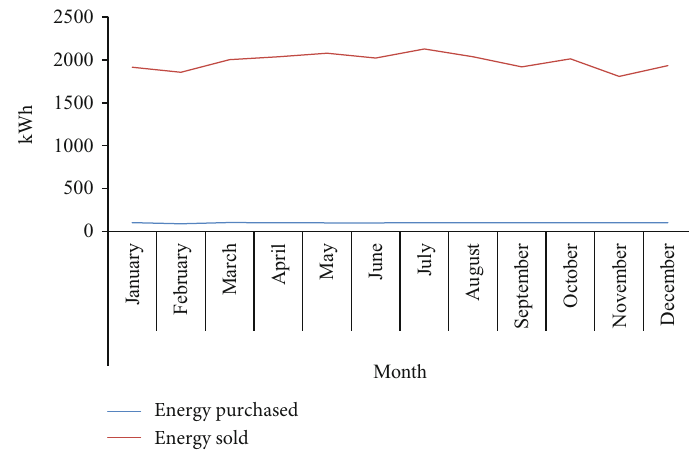
Figure 26: Grid sales against grid purchases for the grid-tied PV